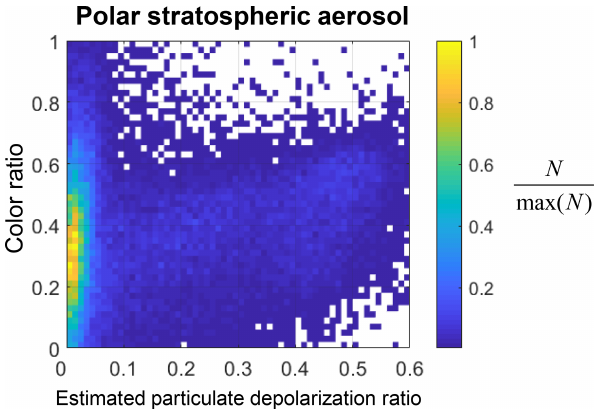
Figure 6. Same joint distributions as Fig. 4 but for layers classified as PSA in the Southern Hemisphere in 2013, based on V4.5 data.